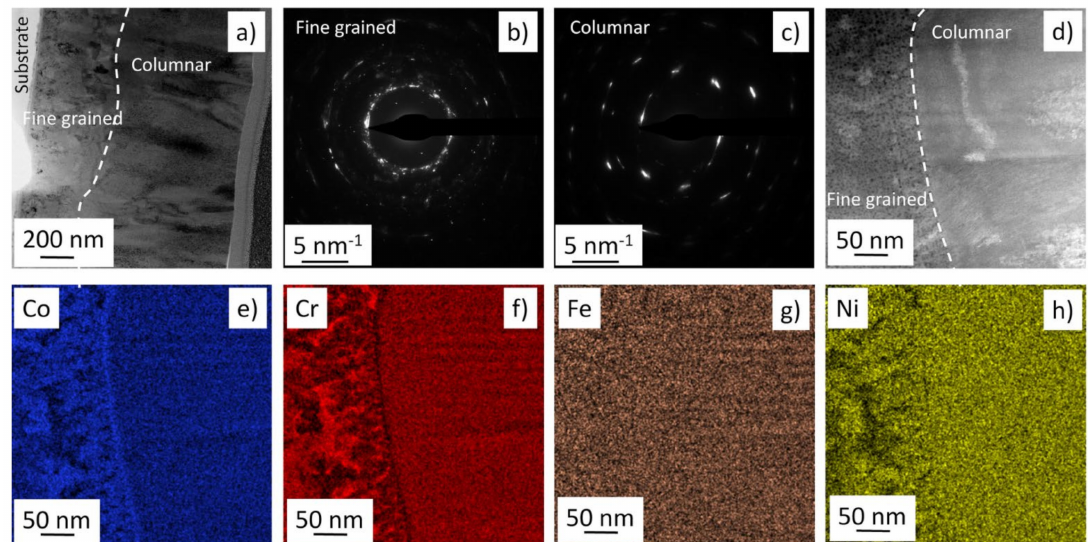
Figure 7. ( a ) Bright-field TEM image showing the cross-section of the layer in the vicinity of point No. 9 where the main phase was hcp. The white dashed curve indicates the boundary between the fine-grained and the columnar regions of the film. SAED patterns taken on the fine-grained ( b ) and columnar regions ( c ). ( d ) HAADF image of a magnified part of the film at the boundary between the fine-grained and columnar regions. The corresponding element maps for the four constituents are shown in ( e – h